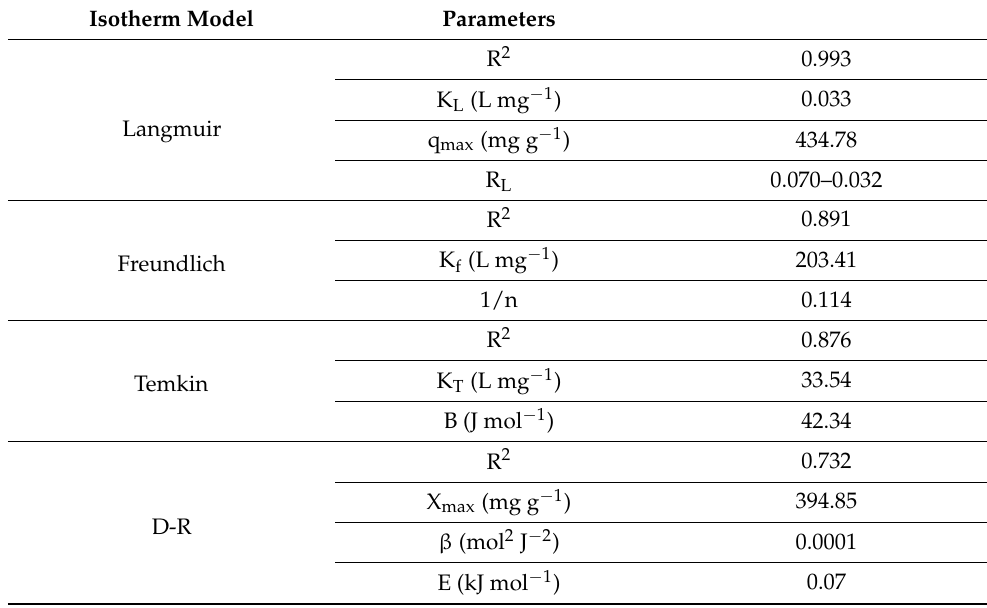
Table 7. Adsorption isotherm constants of CR dye by